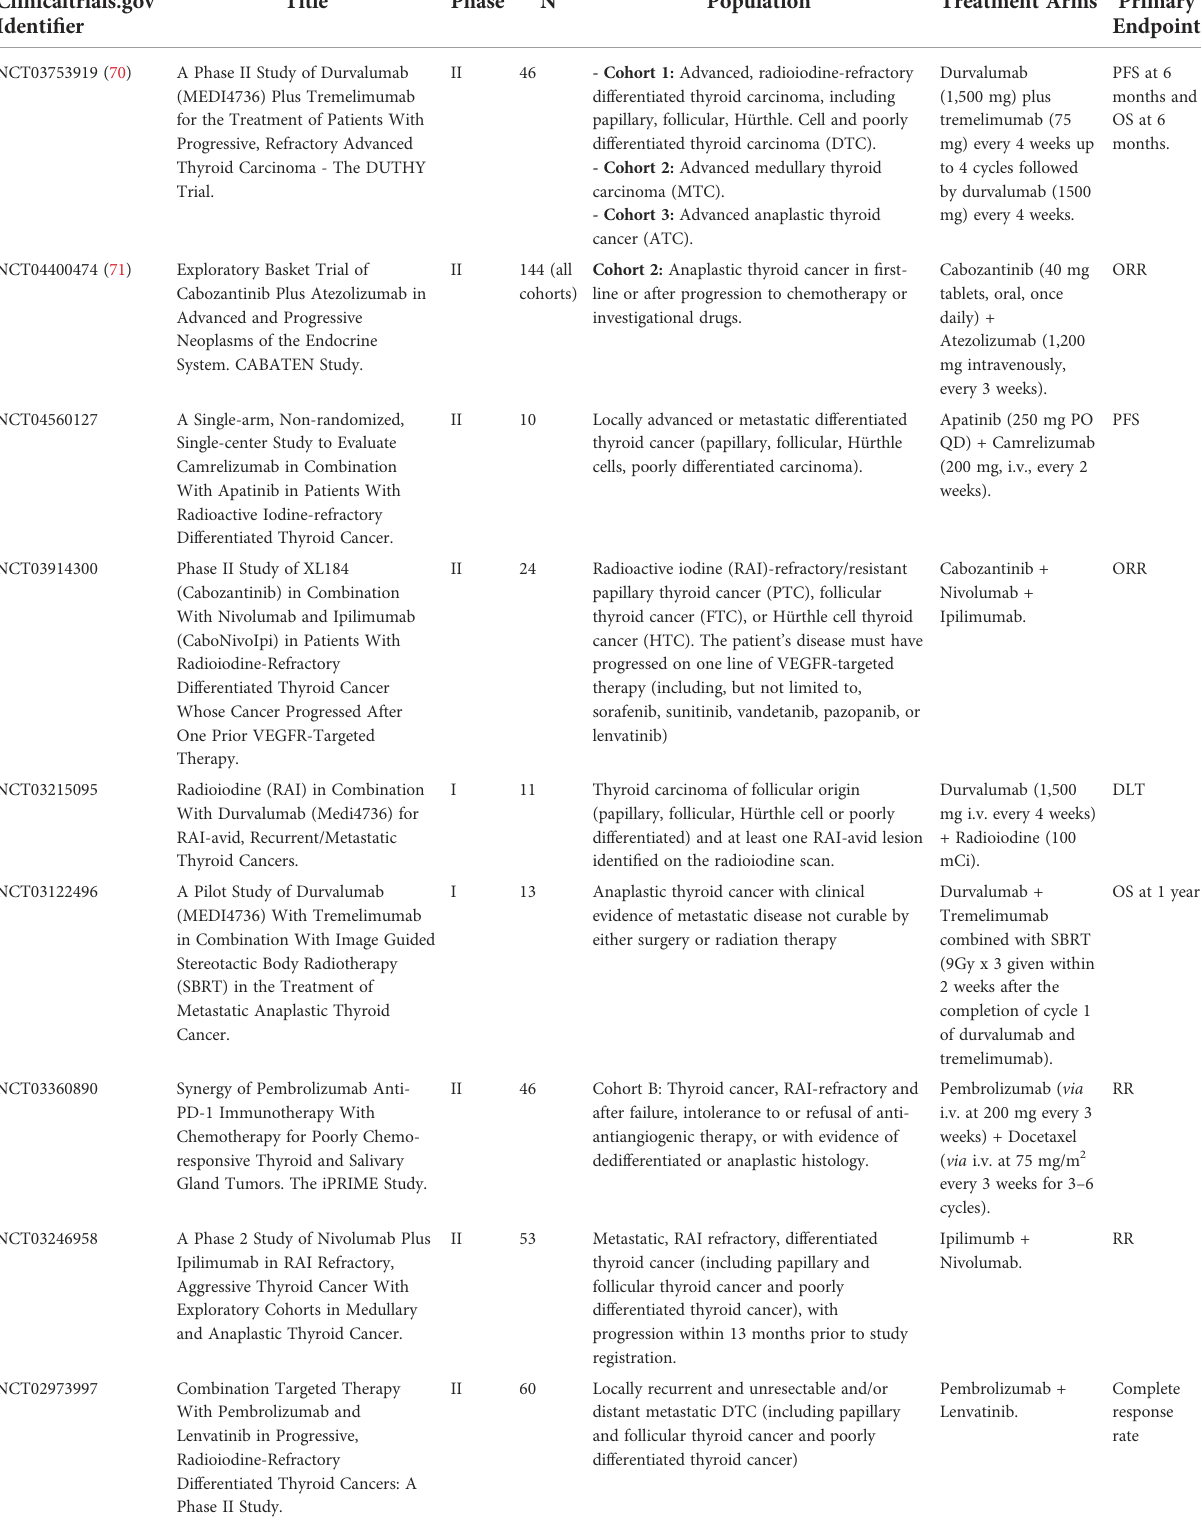
TABLE 2 Ongoing clinical trials involving immunotherapy and combinations with immunotherapy in thyroid neoplasms. Clinicaltrials.gov Identi fi